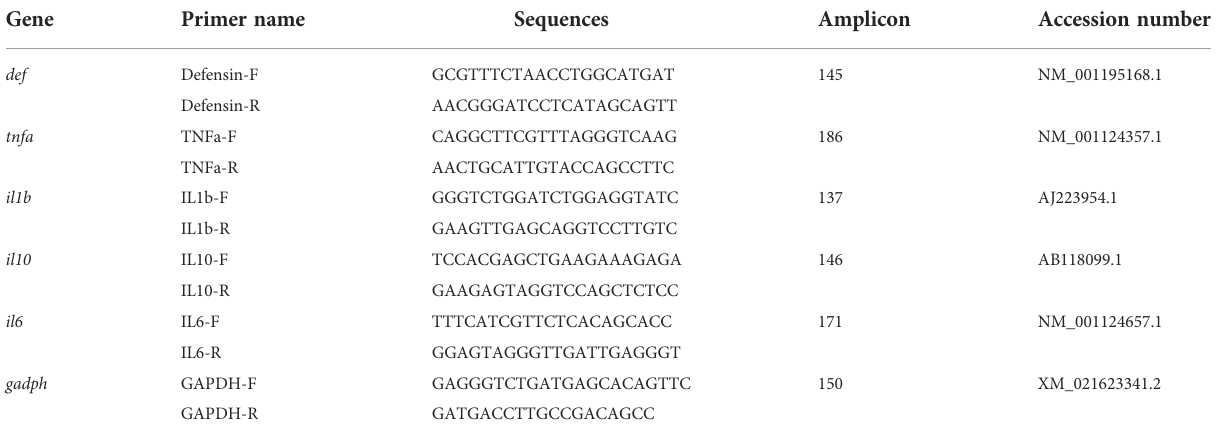
TABLE 2 Sequence, amplicon, and accession number of speci fi c primers used for intestinal transcriptomic